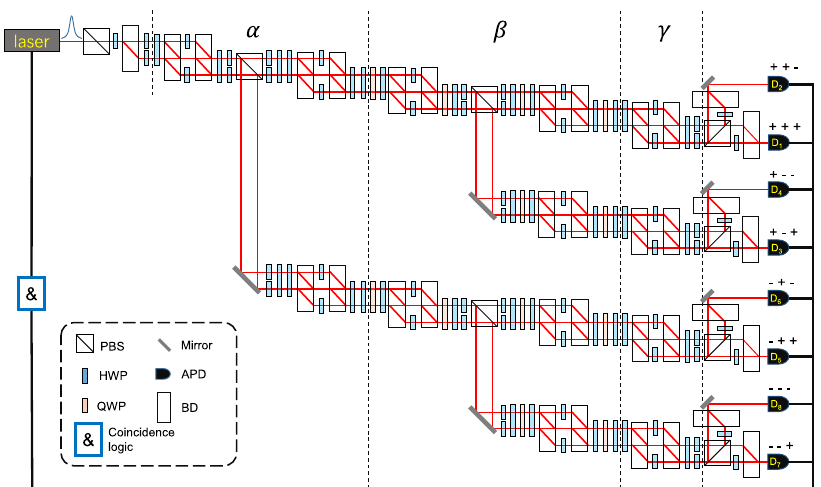
Fig. 4 Schematic set-up for testing contextuality with a coherent light fi eld. Here we use the set of measurement { α , β , γ } as an example. The clicks of eight detectors correspond to the eight outcomes of each set of measurements, respectively, such as D 1 → {1, 1, 1}, D 2 → {1, 1, − 1},